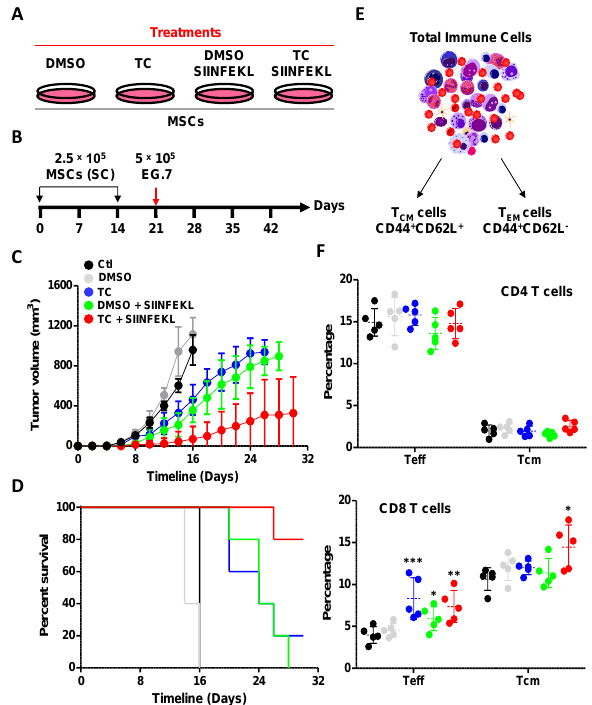
Figure 6. TC treatment enhances the immunogenicity of MSCs in the context of prophylactic vaccination. ( A , B ) Schematic diagrams showing the treatments groups ( A ) and experimental design ( B) used in the vaccination protocol. ( C ) Tumor growth analysis over time. Control unvaccinated mice are shown in black, DMSO-treated MSCs in gray, TC-treated MSCs in blue, SIINFEKL-pulsed DMSO-treated MSCs in green, and SIINFEKL-pulsed TC-treated MSCs in red. ( D ) Kaplan–Meier survival curve for the experiment shown in panel ( C ). ( E , F ) Analysis of T CM , and T Eff CD4 and CD8 T cells in vaccinated animals. Ctl mice are shown in black, DMSO in green, TC in red, DMSO + SIINFEKL in purple, and TC + SIINFEKL in blue. For this panel, n = 5/group with * p < 0.05, ** p < 0.01, and *** p < 0.001